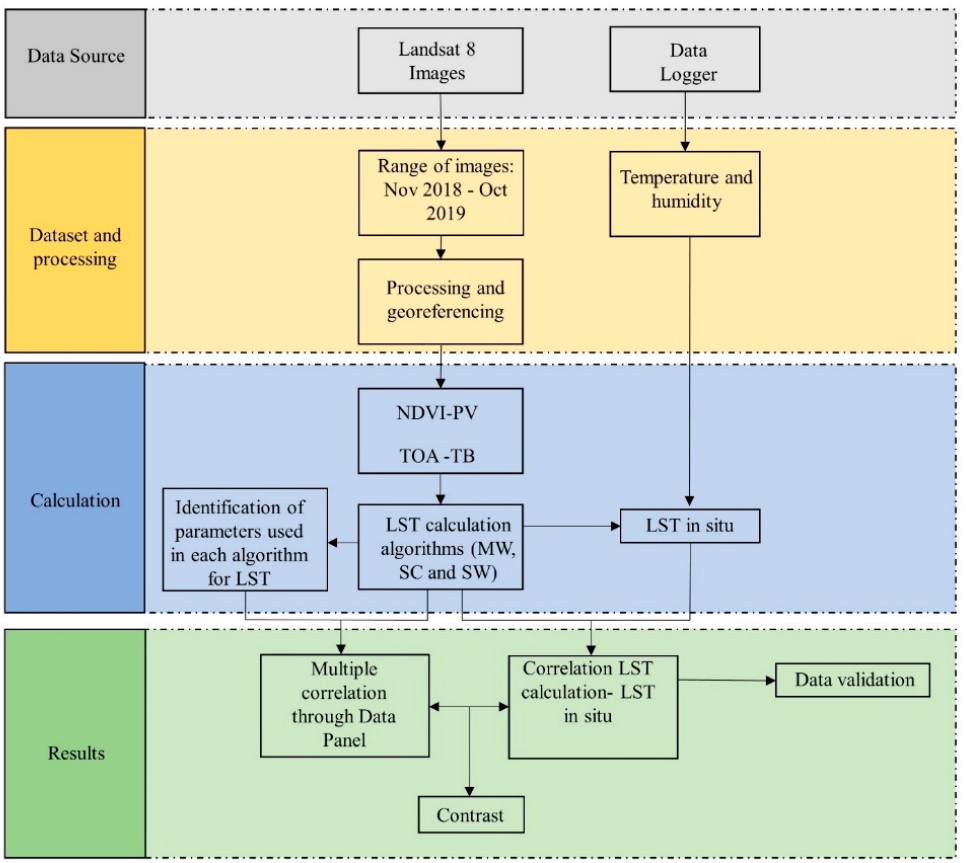
Figure 2. Methodology: Data processing.